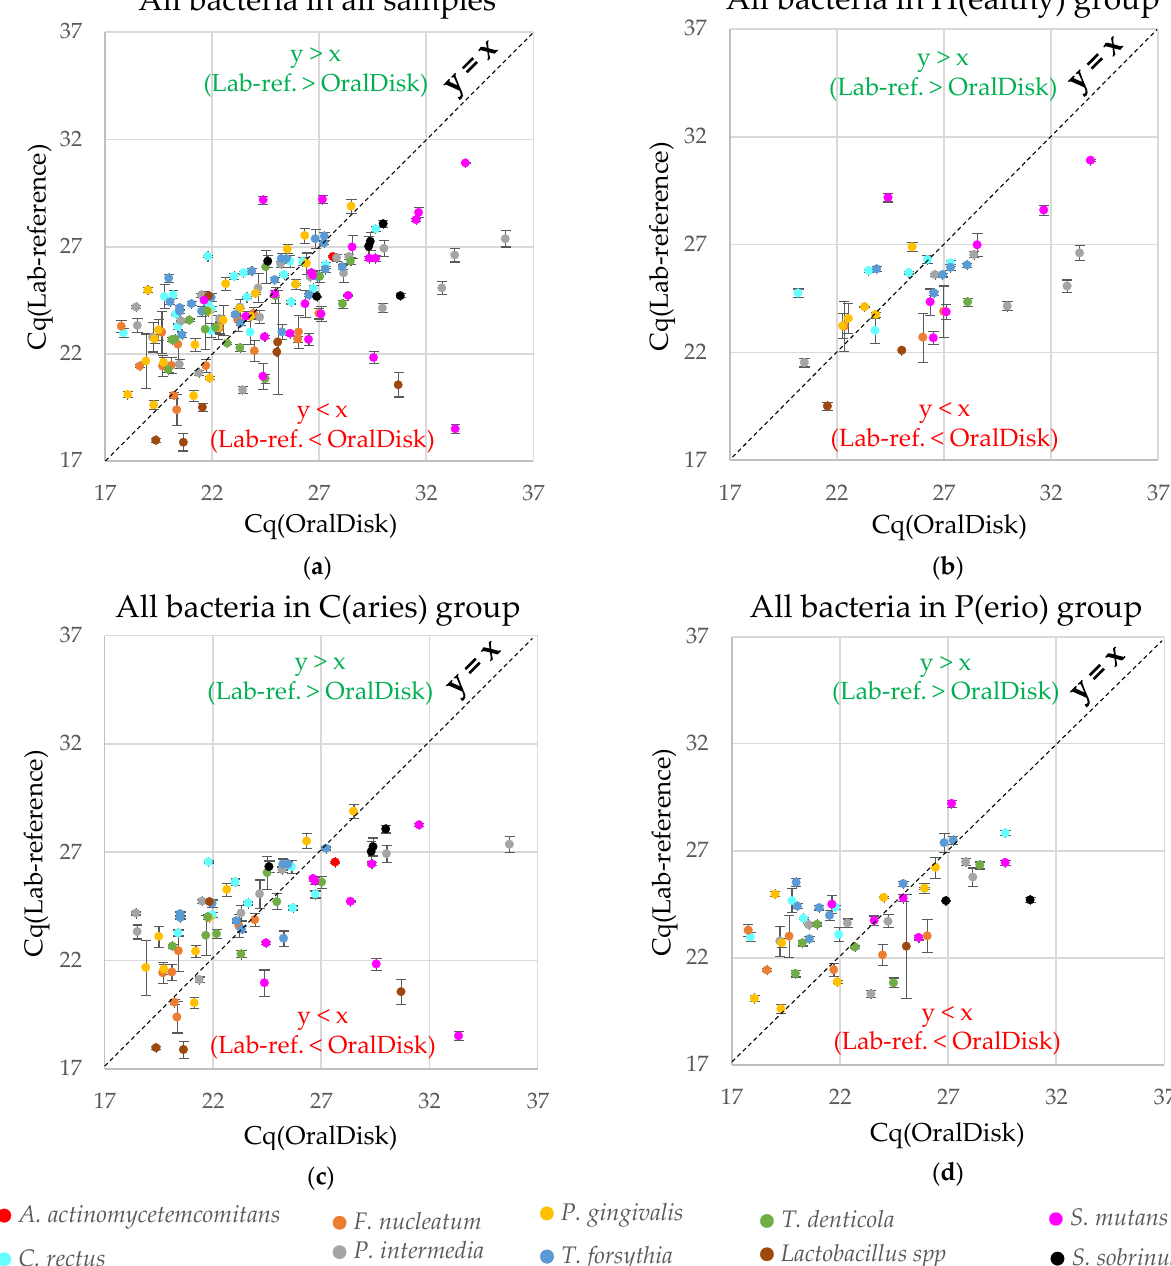
Figure 5. Scatter plots correlating the Cq values from the OralDisk and the lab-based reference for all bacteria: ( a ) in all three groups; ( b ) in the healthy group; ( c ) in the caries group; and ( d ) in the periodontitis group. Similar scatter plots for each individual bacterium are depicted in the Supplementary Figure S2.